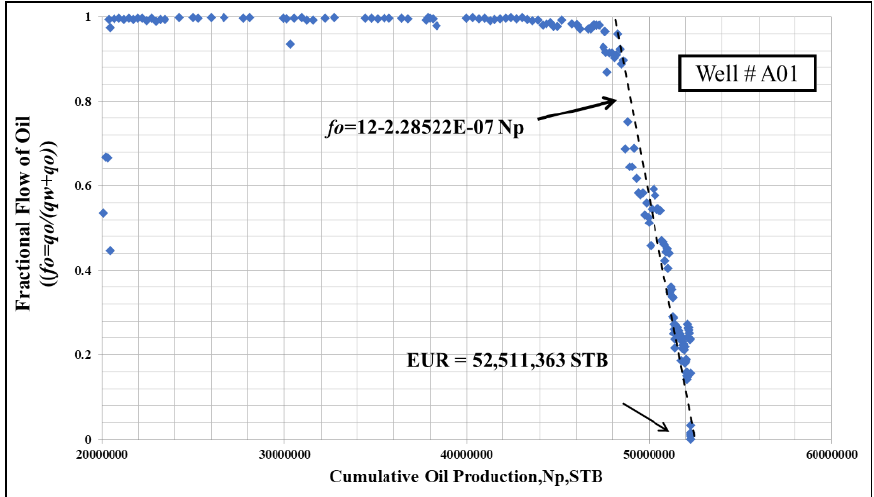
Figure 14. Fractional flow of oil versus cumulative oil production for well A01